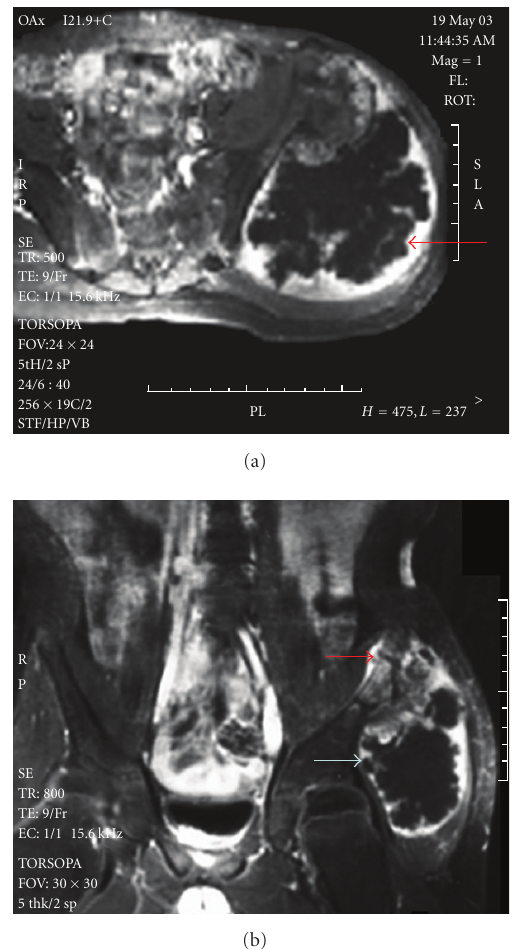
Figure 1: (a) Axial MRI images of the iliac mass reveal its enlarged cartilage cap of 5-6cm thickness and the nodular or ring and arc enhancement (large arrow). (b) Coronal MRI images reveal the enlarged cartilage cap, nodular or ring and arc enhancement (large arrow), and invasion of the inner table cortex by tumor (small arrow).